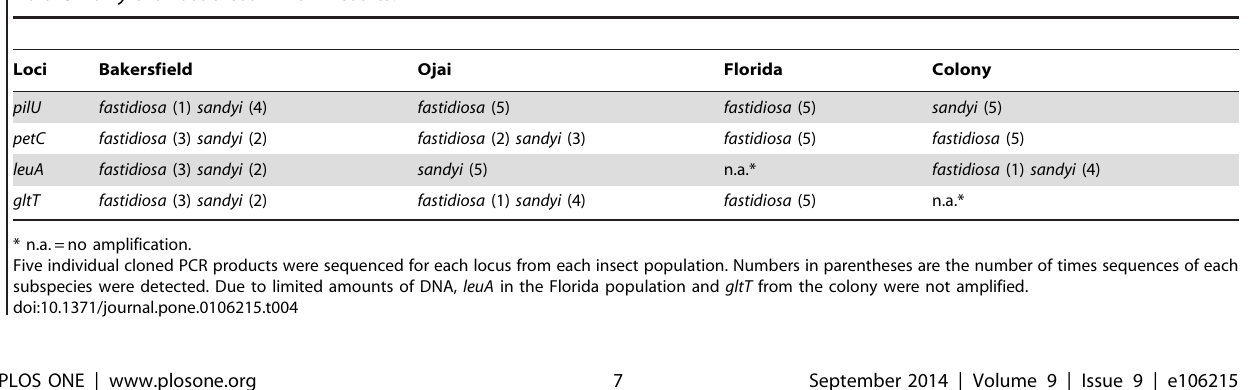
Table 4. Xylella fastidiosa MLST